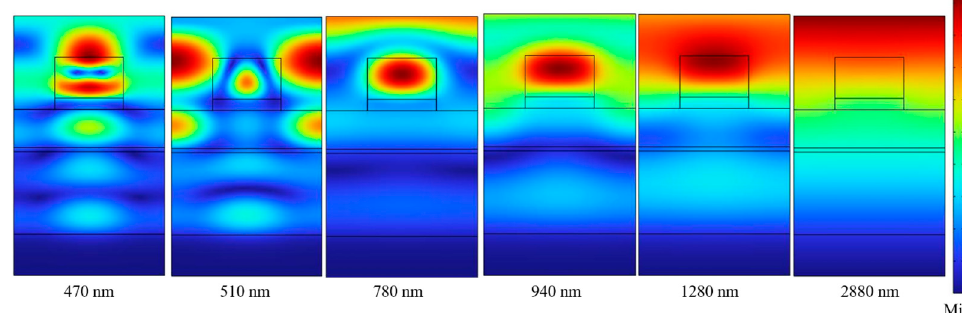
Figure 7. Distributions of magnetic field intensities under normal incident TE polarized light with different exciting wavelengths.